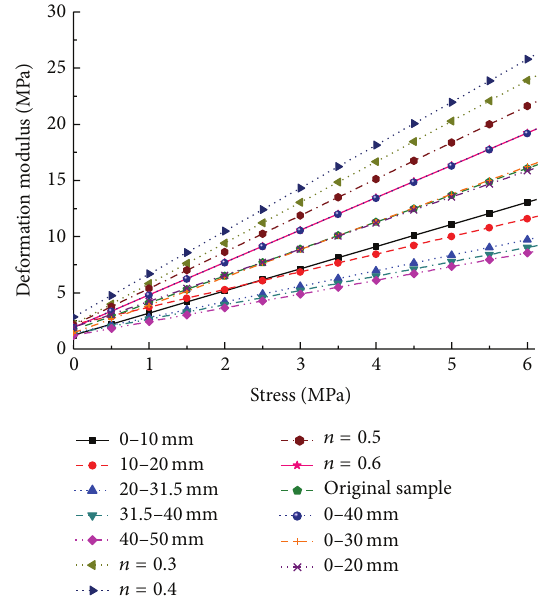
Figure 4: Stress versus deformation modulus for all graded